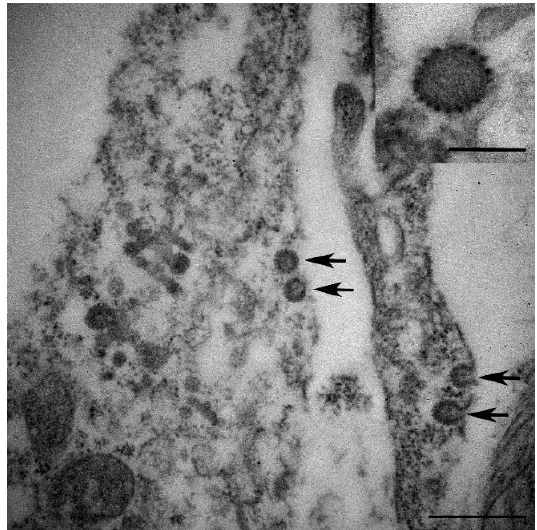
Figure 4. Electron microscopy of gills from CEV-affected koi. Few number of virions present in the cytoplasm (arrows). Scale bar = 500 nm. (Inset) Virion showing electron dense core with surface membrane worn by surface globular units. Scale bar = 200 nm.